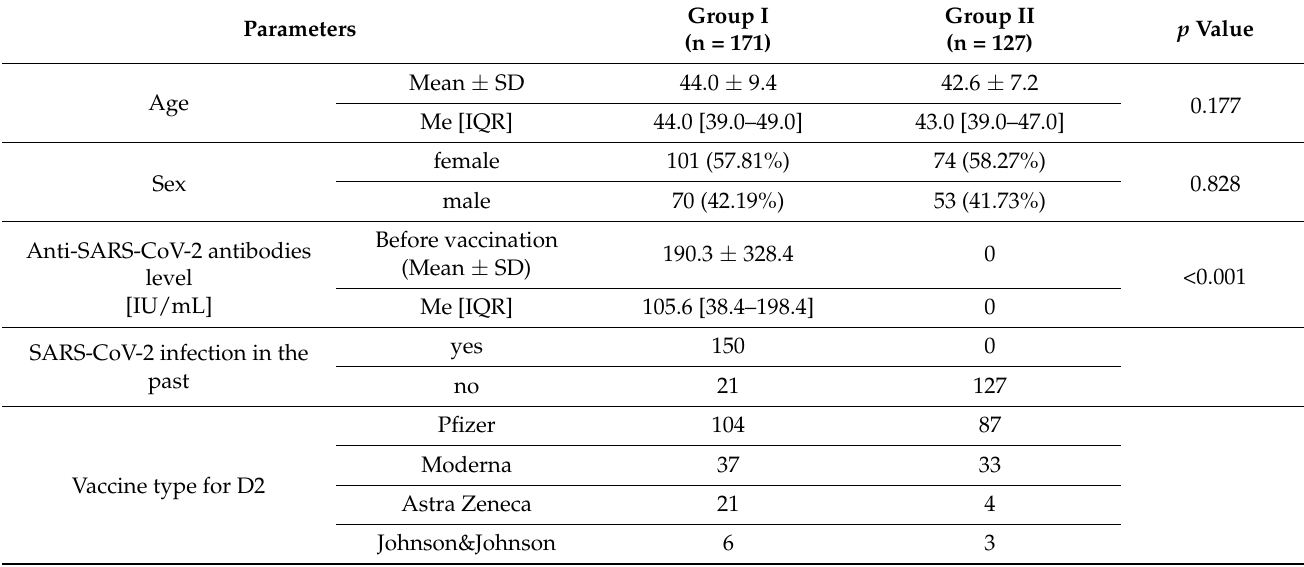
Table 1. Characteristics of the